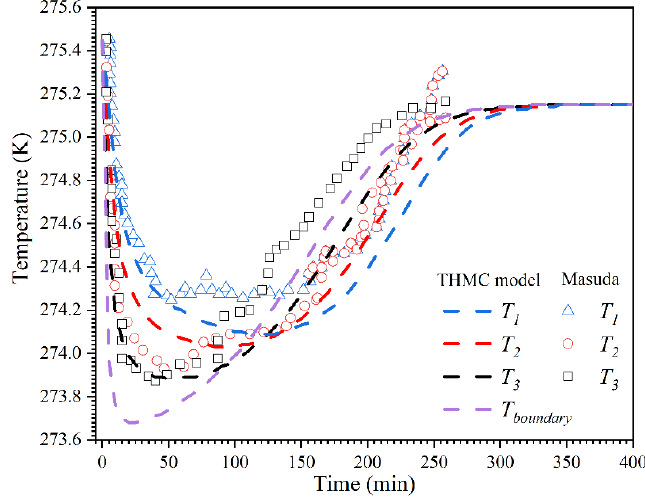
Figure 5. The temperature data at 1 mm ( T boundary ), 75 mm ( T 3 ), 150 mm ( T 2 ) and 225 mm ( T 1 ) from the outlet boundary.